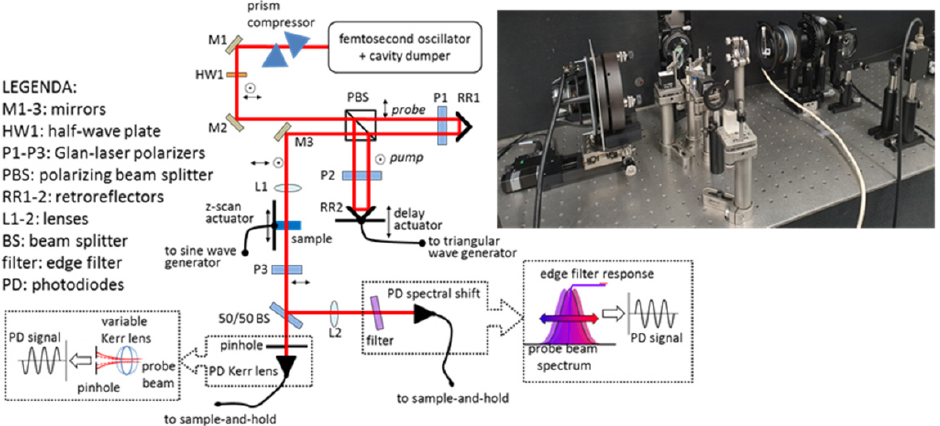
Figure 1. Layout of the experimental apparatus and picture of the ISRS interferometer with the schematics of the principles of operation of the Kerr lens and spectral shift detection assemblies. A photo of the interferometer and signal detection sections is also shown.